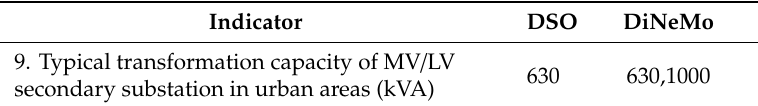
Table 6. Typical transformation capacity comparison for industry area.